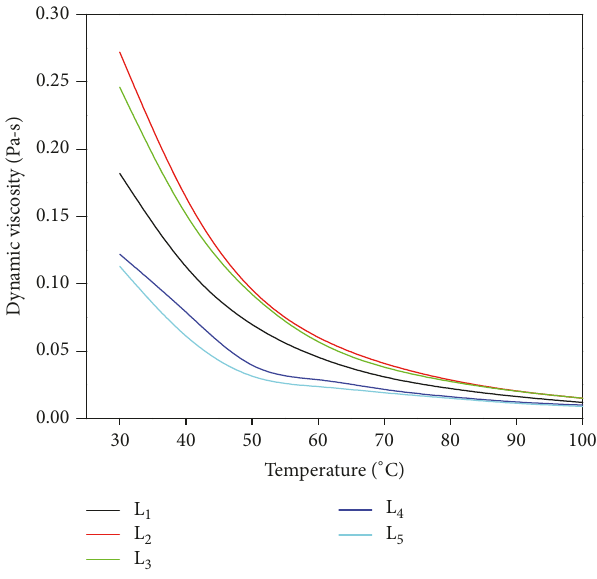
Figure 3: Variation of viscosity with temperature.